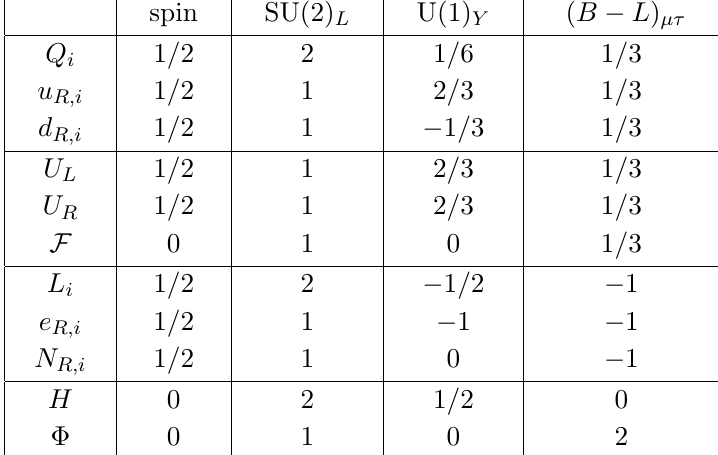
Table 1 . Field content and quantum numbers in the minimal ( B (cid:0) L ) (cid:22)(cid:28) extension; here i = 2 ; 3 and the (cid:12)rst generation of fermions which are neutral under this new gauge group are not listed. In the doublet (cid:13)avon model, vectro-like quarks are replaced by H (cid:22)(cid:28) which has the same quantum numbers as H except for carrying 1/3 charge under ( B (cid:0) L ) (cid:22)(cid:28)